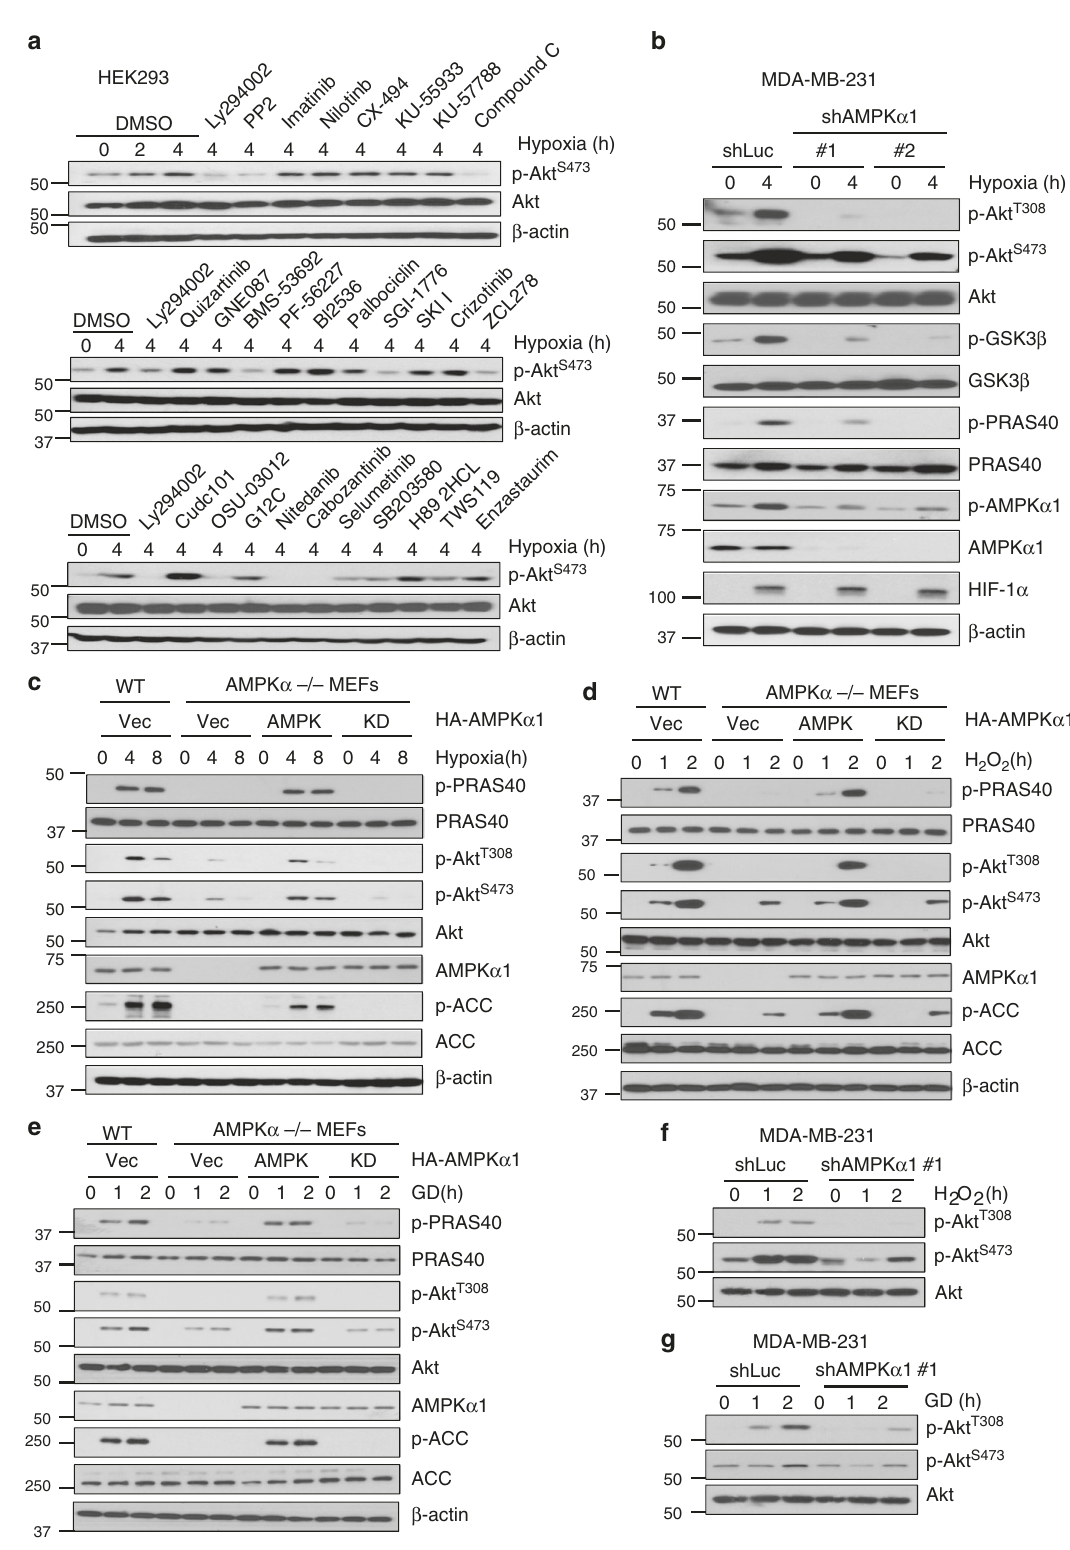
Fig. 1 AMPK is required for Akt phosphorylation and activation under various cellular stresses. a Screening of kinases in the hypoxia-induced Akt phosphorylation using kinase inhibitor library. Immunoblotting of HEK293 cells pretreated with indicated inhibitors at 10 μΜ for 2 h and challenged with 1% O2 for another 4 h. b Immunoblotting of control (shLuc) and AMPK α 1 knockdown MDA-MB-231 cells (#1, #2) treated with 1% O2 for 4 h. c – e Immunoblotting of WT and AMPK α 1/ α 2 double knockout ( AMPK α -/- ) restored with vector, WT or kinase dead AMPK α under hypoxia (1% O 2 ), 100 μΜ H 2 O 2 or glucose deprivation for indicated time. In each restoration experiment, 5 μ g of the plasmid was transfected into indicated cell lines. f , g Immunoblotting of with control (shLuc) and AMPK α 1 knockdown MDA-MB-231 cells under H 2 O 2 (100 μΜ ) or glucose deprivation for indicated